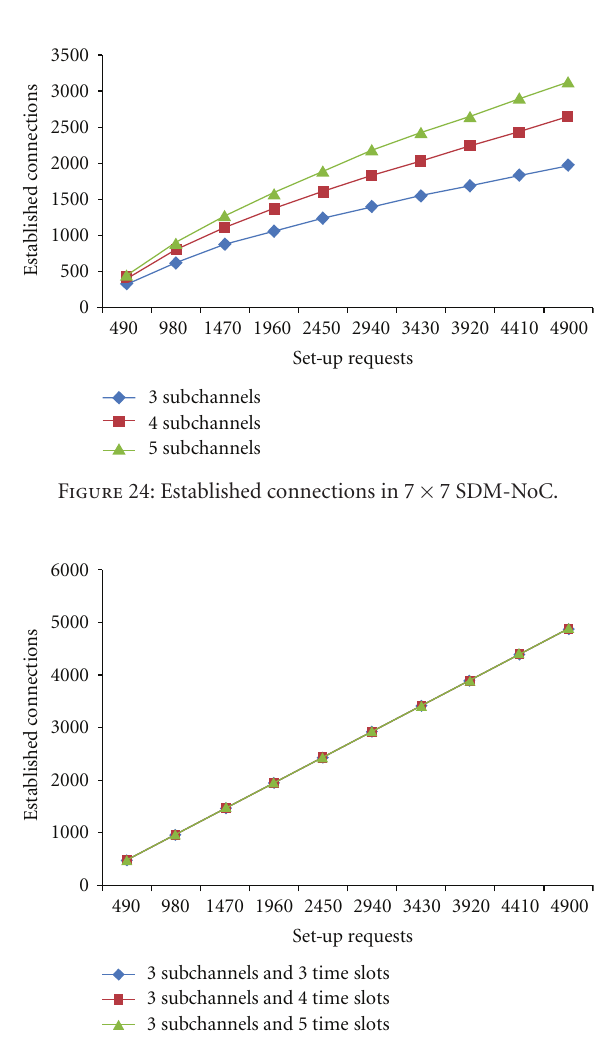
Figure 25: Established connections in 7 × 7 SDM-TDM NoC.